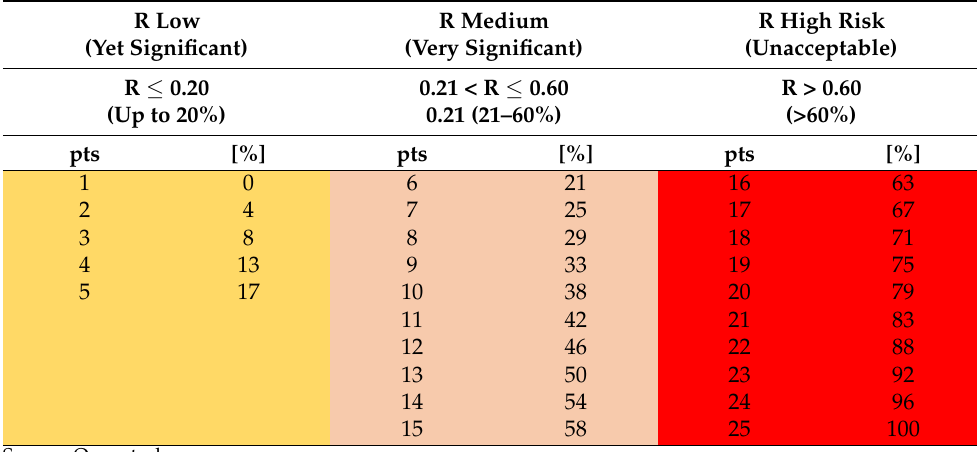
Table 4. Numerical values and verbal interpretation for a given Risk scale